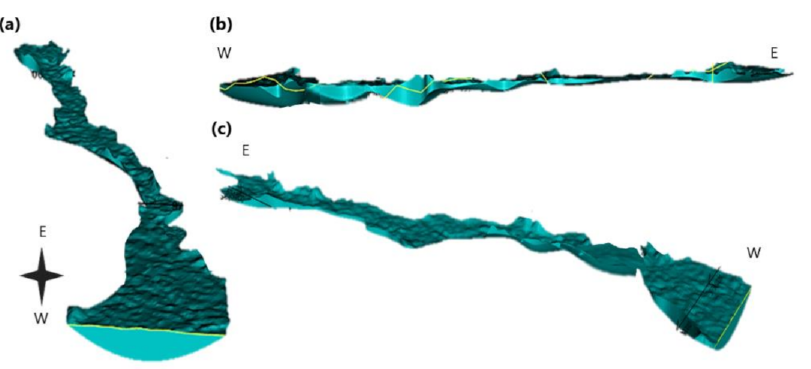
Figure 12. Different views of the aquifer geometric model. ( a ) Front west–east view direction. ( b ) South side view in a west–east direction; ( c ) north side view in an east–west